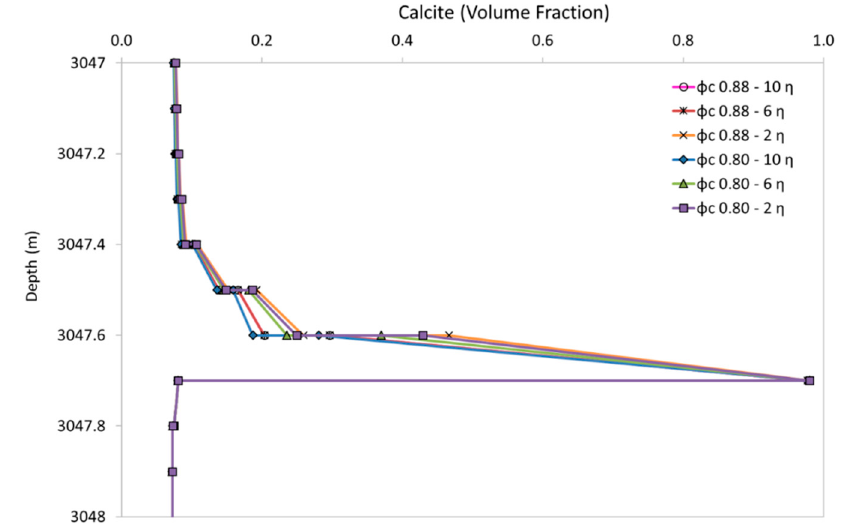
Figure 7. The calcite content for a 1 m section of the microannulus after leakage remediation, showing a peak adjacent to the level of reactive solution injection. The results are shown for six scenarios of di ff erent porosity-permeability relation input parameters. Table 5. The predicted time of remediation up to full clogging of the microannulus.